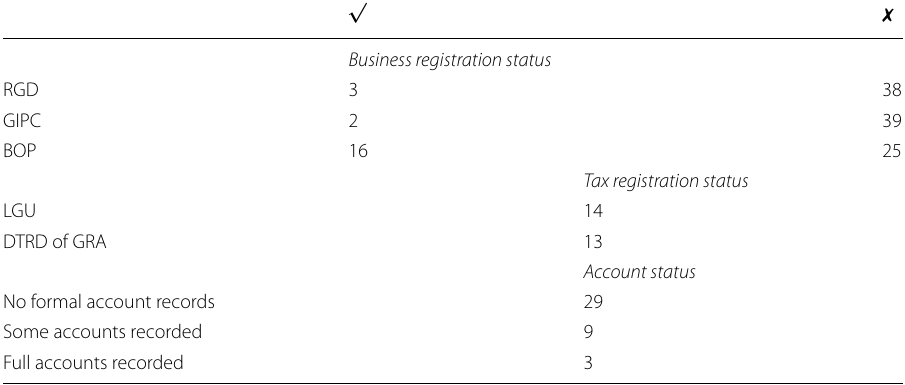
RGD, Registrar general’s department; GIPC, Ghana investment promotion centre; BOP, business operation permits, LGU, local government units; DTRD, domestic tax revenue division; GRA, Ghana revenue